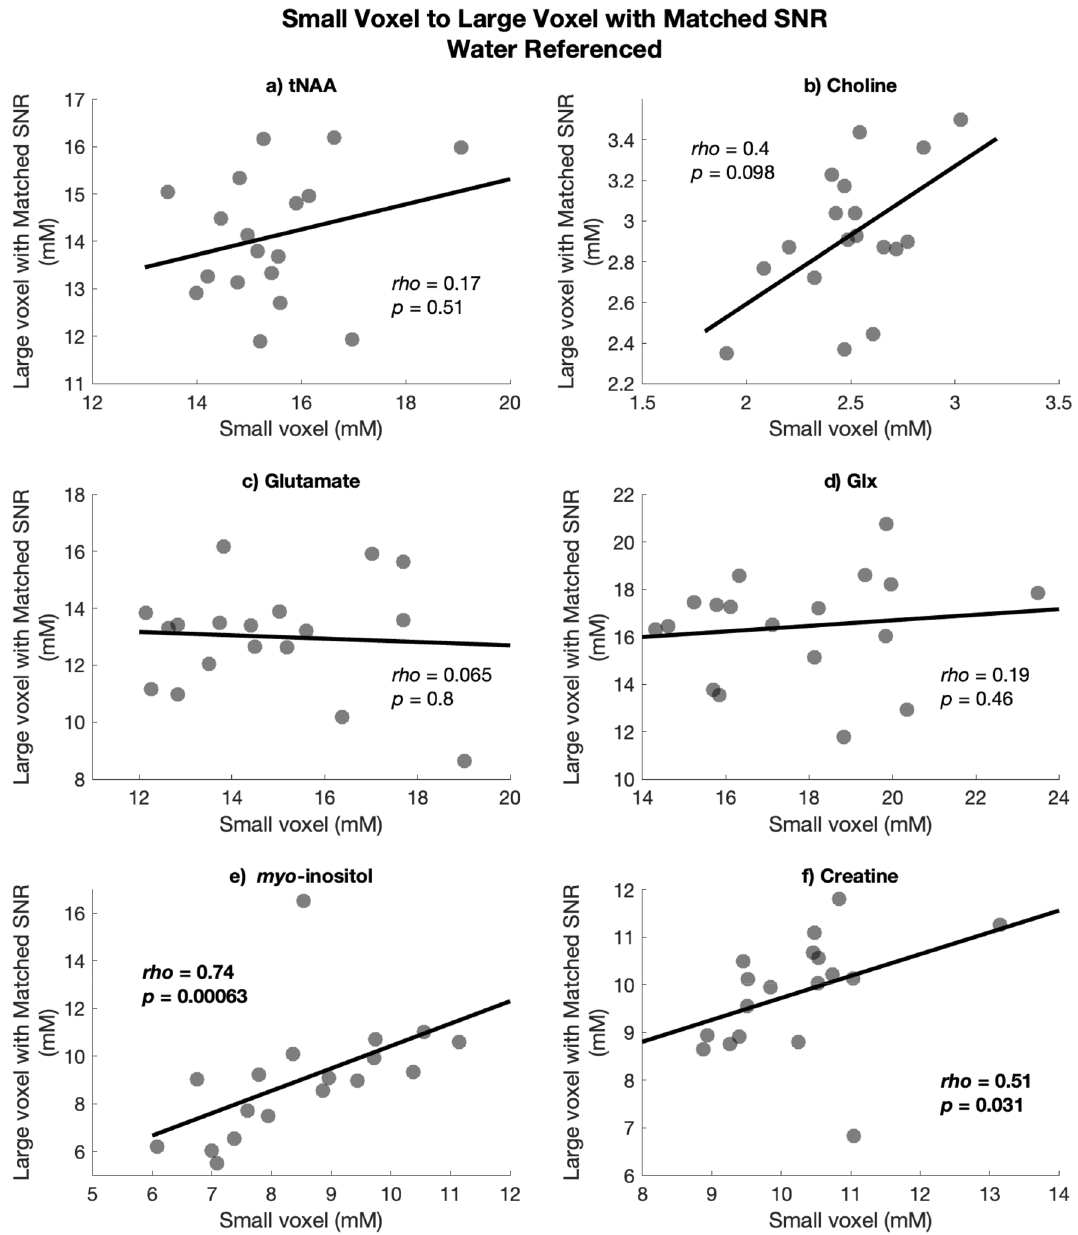
Figure 7. Spearman’s rho correlations between water-referenced (milli-molal) values in the large voxel with matched SNR on the y-axis and the small voxel on the x-axis for ( a ) tNAA, ( b ) Choline, (c) Glutamate, ( d ) Glx, ( e ) myo-inositol and ( f )